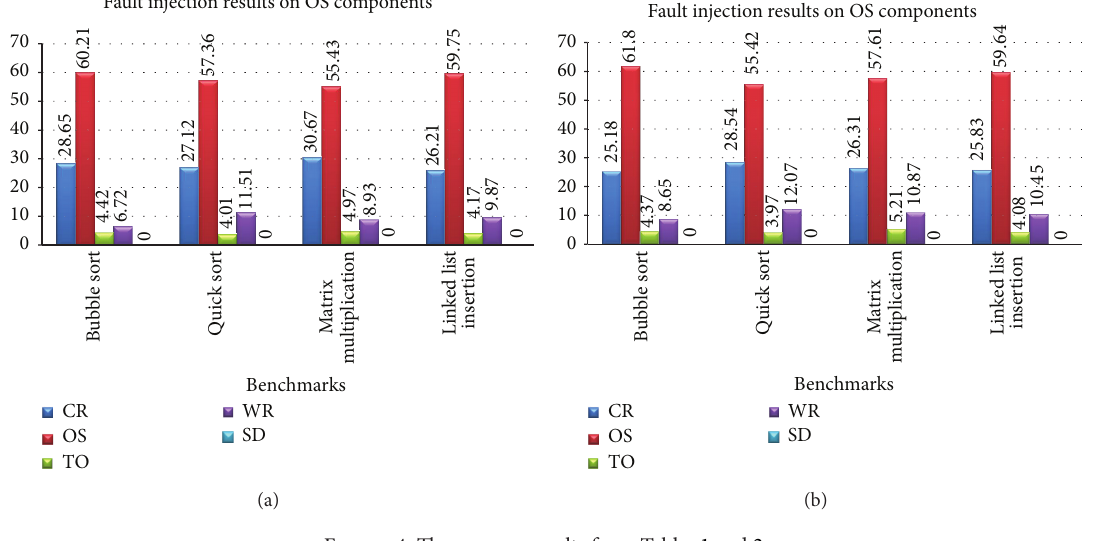
Figure 4: The average results from Tables 1 and 2.